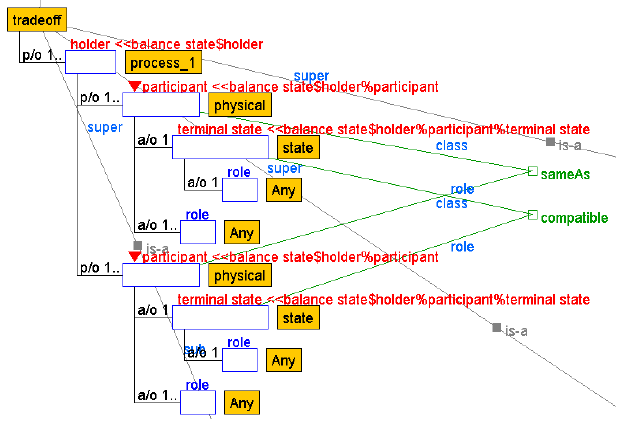
Figure 5. The structure of the concept of trade ‐ off in the water–energy–food (WEF) nexus domain ontology.